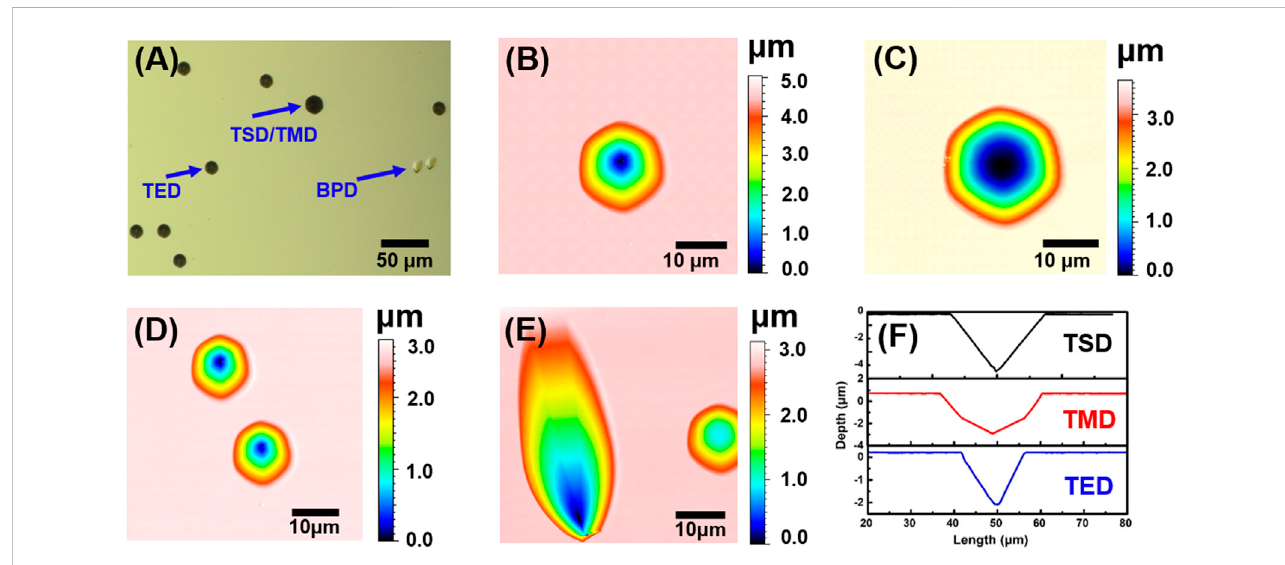
FIGURE 1 Representative OM images of etched 4H-SiC epitaxial layer samples (A) , the LSCM images of (B) TSD, (C) TMD, (D) TED, (E) BPD and depth pro fi les (F) .